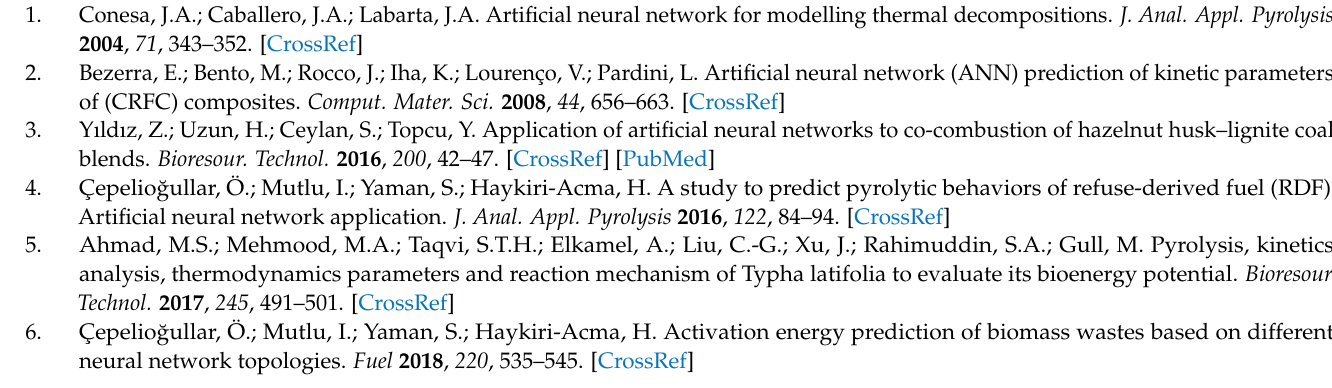
Figure 7. Error histogram of simulated data for ( i ) AN7-A, ( ii ) AN7-B.